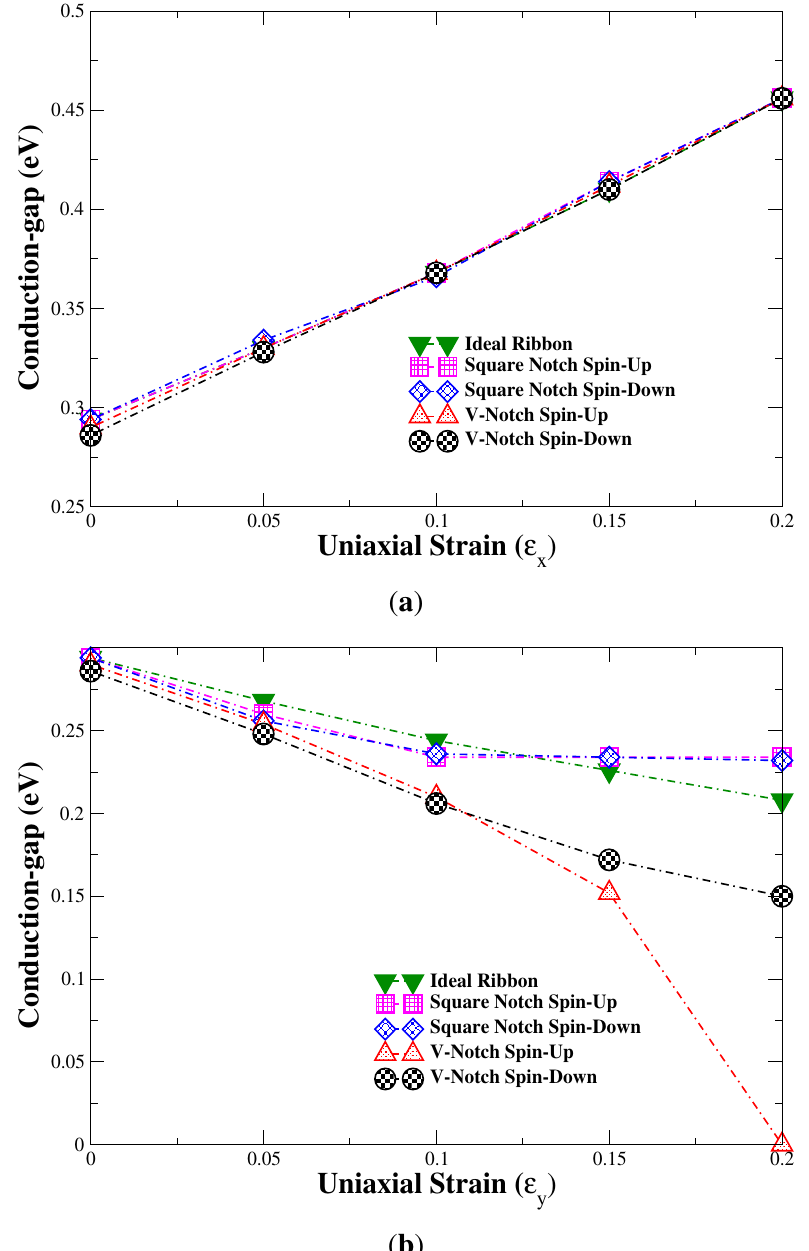
Figure 5. (Color on-line). The effects of uniaxial strain in the ( a ) x -direction, and ( b ) y -direction on the spin-dependent conduction-gap for the ideal, square notch and V-shaped notch ZGNR systems. The results for the ideal ribbon show similar trends to the band gap results reported in